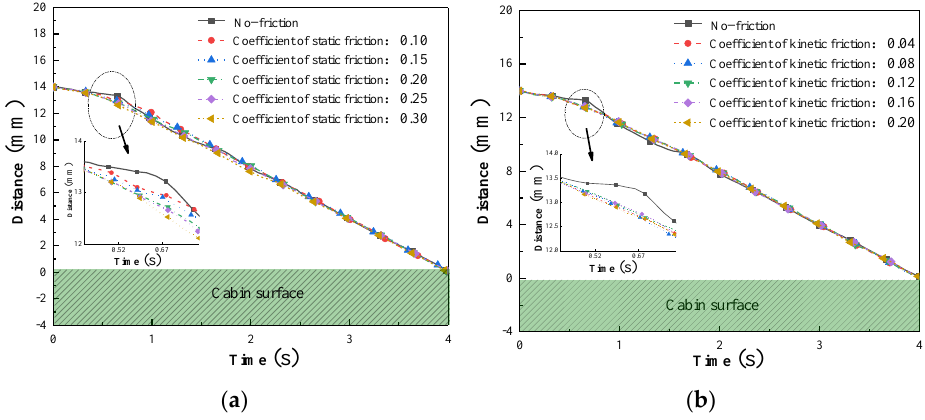
Figure 16. Effect of friction coefficient on the locking process of the locking module. ( a ) Coefficient of static friction. ( b ) Coefficient of kinetic friction.